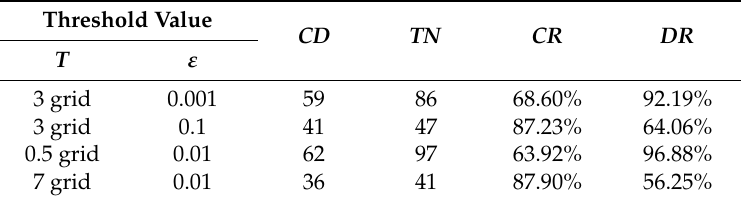
Table 5. Threshold value settings and